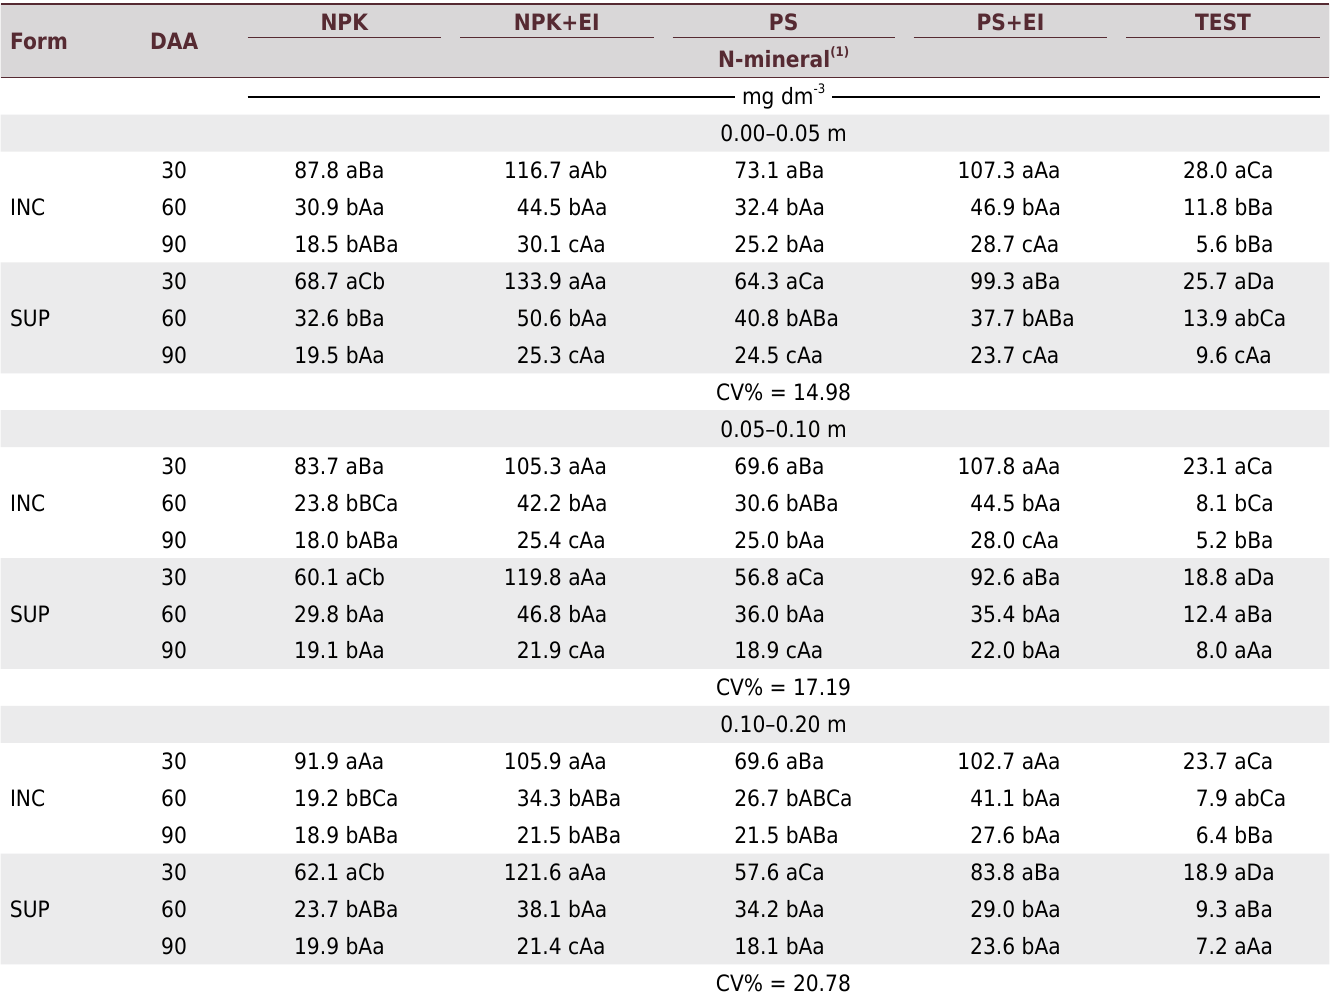
Table 3. N-mineral content in the soil layers 0.00-0.05 m, 0.05-0.10 m, and 0.10-0.20 m in a Cambissolo Húmico Álico (Humic Cambisol) after three years of fertilizations with mineral fertilizer (NPK), mineral fertilizer plus enzyme inhibitors (NPK+EI), pig slurry (PS), pig slurry plus enzyme inhibitors (PS+EI), and control without fertilization (TEST) with applications forms on soil surface (SUP) and incorporated into the soil (INC), determined at the times 30, 60, and 90 days after the fertilizers application (DAA). Means of four